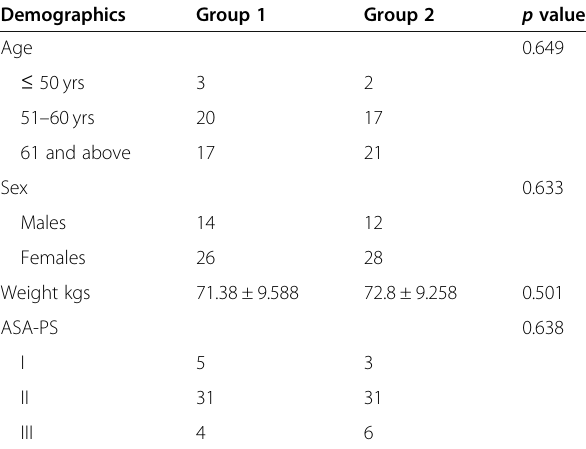
Table 1 Comparison of the demographic data